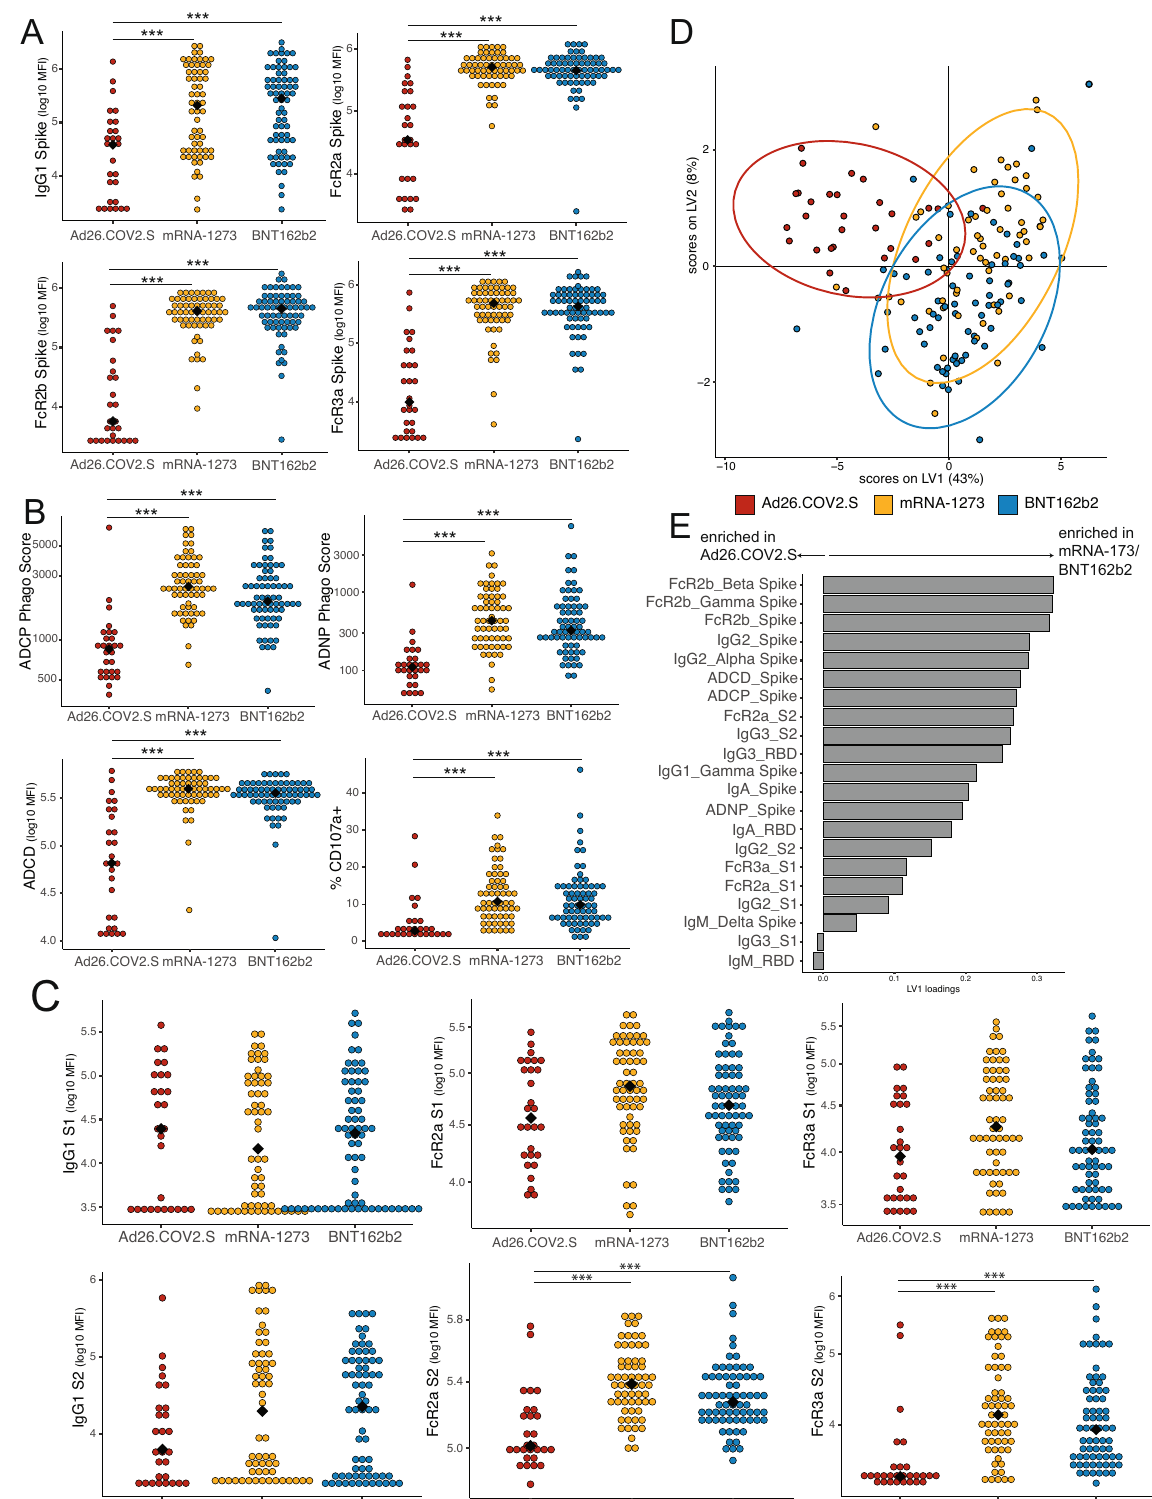
Fig. S2C). While the proportion of individuals with neutralizing activity against Omicron (39%) is lower than what has been previously reported against the ancestral virus 15,17,50 , the reduced neutralizing activity against Omicron observed here is consistent with studies in non-pregnant individuals and limited available data in pregnancy 51 – 55